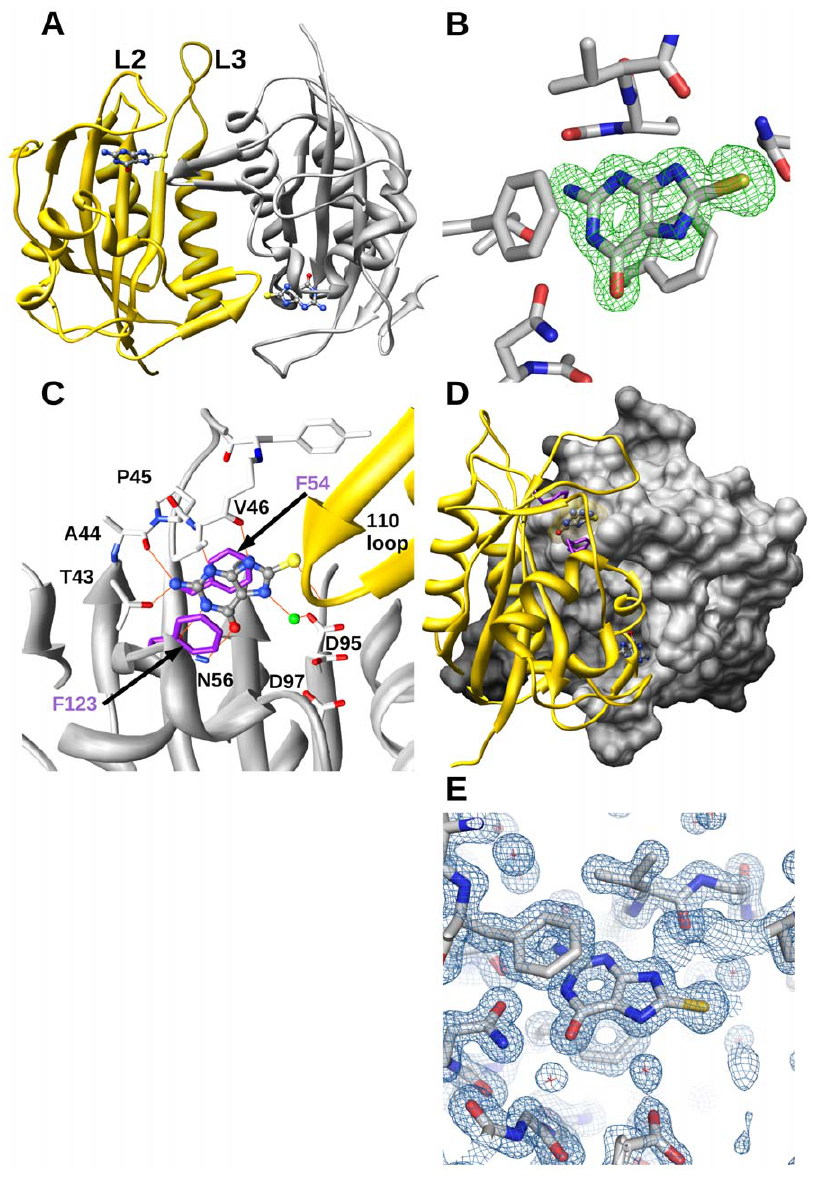
Figure 5. X-ray structure of SaHPPK with the 8-mercaptoguanine inhibitor bound. A Ribbonschematicshowingthecrystallographicdimer of theSaHPPK-8-mercaptoguanine binary complex. B, F 0 -F c difference density map of 8-mercaptoguanine contoured at 3.0 sigma. C, Intermolecular interactions (orange) involving 8-mercaptoguanine. Two side chain conformers for Asp95 were modelled and are shown. The second monomer is drawn in yellow ribbon. The oxygen atom of a water molecule forming hydrogen-bonds with 8-mercaptoguanine and SaHPPK is shown in green. D, Space filling representation of thedimer interface, showing 8-mercaptoguanine bound in thedeep pterinpocket,sandwiched between Phe123 and Phe54 (purple), and illustrating the proximity to the 110 s loop in the other monomer. E, Final 2F 0 -F c electron density map of the pterin binding site, contoured at 2.0